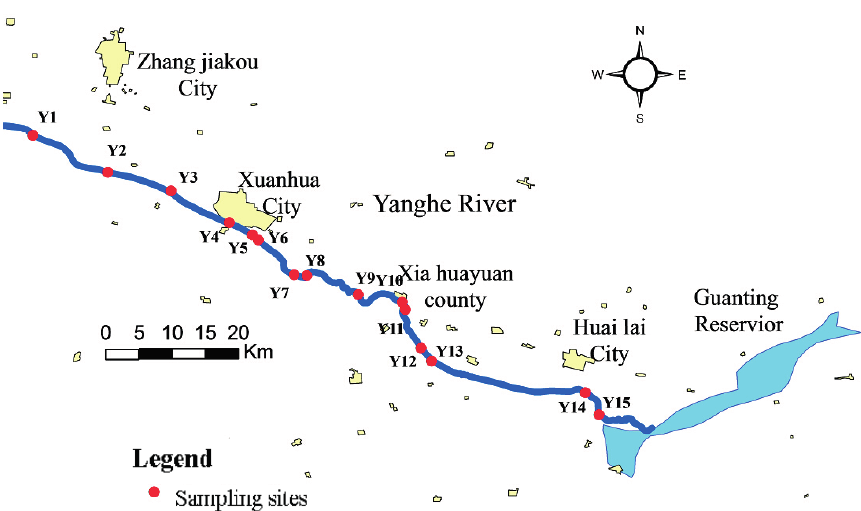
Figure 1. Sampling sites along the Yanghe River.